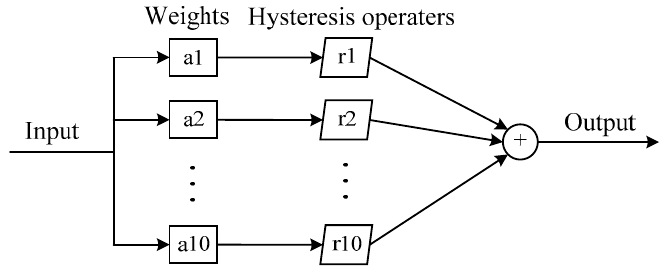
v r r − Figure 13. Schematic diagram of play hysteresis operator.